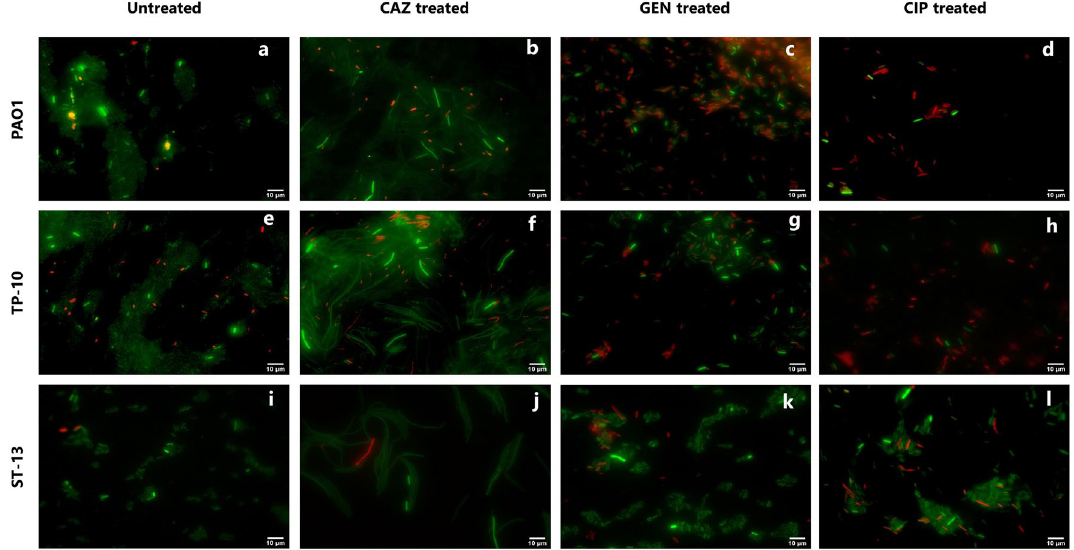
Figure 3. Fluorescence Microscopy of PCs in the planktonic stage. The representative images of PAO1, TP-10, and ST-13 isolates, after 4 h of ( a,e,i ) without antibiotic treatment and with ( b,f,j ) CAZ ( c,g,k ) GEN ( d,h,l ) CIP antibiotic treatments, which were grown in LB. Before staining the cells were washed to remove antibiotics and stained with RSG and PI dyes. ( a,e,i ) Untreated cells were used as control. Cellular redox activity was measured by RSG staining. CAZ: ceftazidime, GEN: gentamicin, and CIP: ciprofloxacin. Images were analysed using Fiji